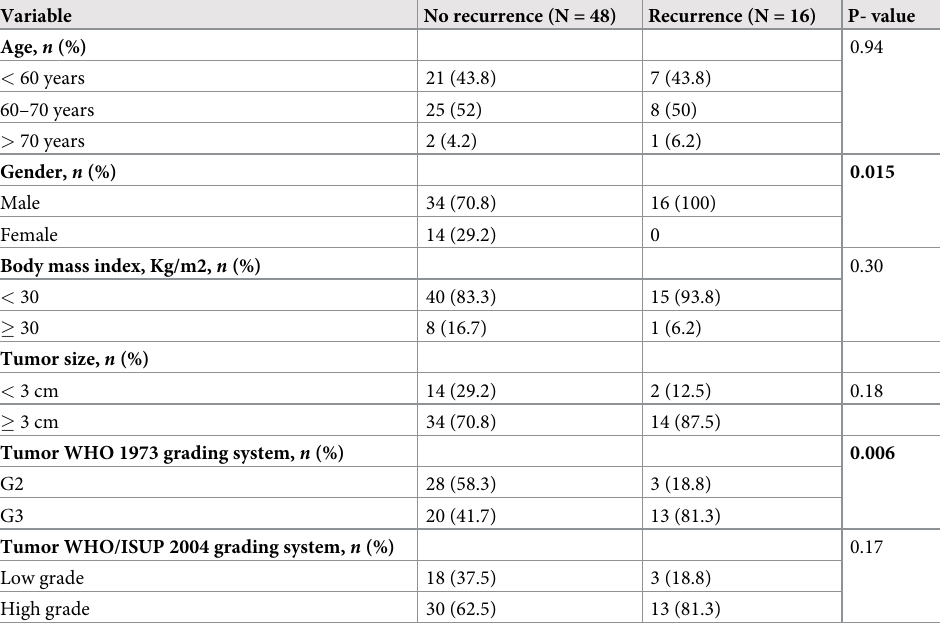
Table 3. Analyses for predictors of recurrence among NMIBC